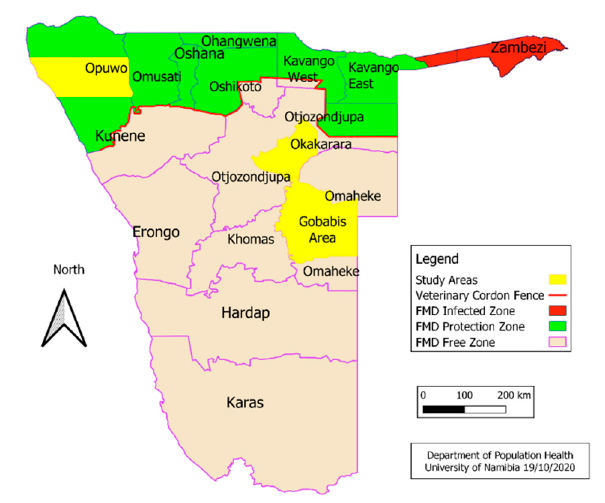
Figure 1. Namibia regional map showing the foot and mouth disease (FMD) zones and fences and study areas for commercial (Gobabis area), semi-commercial (Okakarara area) and communal farming (Opuwo area) [4], (source Dr Alec Bishi).